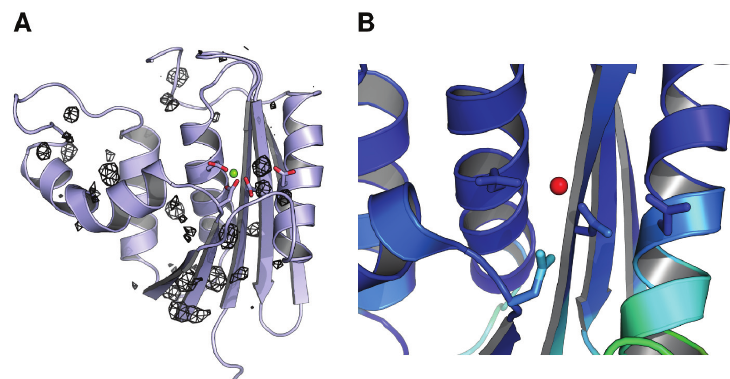
Figure 4. Mg 2+ ion dynamics in a simulation initiated from the ecRNH Mg 2+ -bound crystal structure. ( A ) Occupancy map from an 89ns simulation initiated from the ecRNH structure solved in the presence of Mg 2+ (PDB ID 1RDD), contoured to 0.05% occupancy (corresponding to at least 45ps total residence time). The ion exits the active site and interacts with a variety of regions on the protein surface. ( B ) The active- site region of the 1RDD structure, colored by atomic B-factor. The B-factor of the ion is substantially larger than the surrounding residues, and